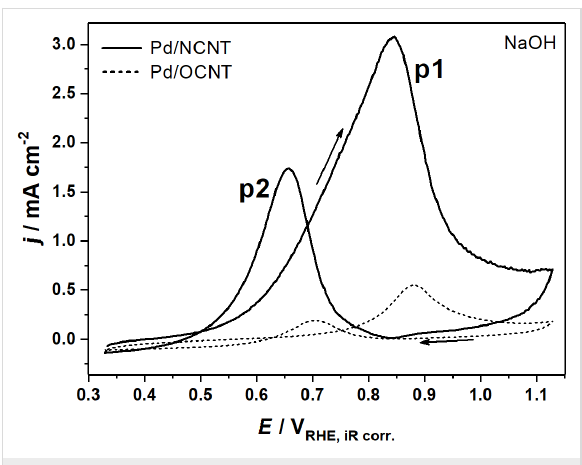
Figure 2: CVs of the electrooxidation of 1 M glycerol over Pd/NCNT- NH 3 and Pd/OCNT-He in 1 M NaOH at 1000 rpm at a scan rate 0.01 V s − 1 .